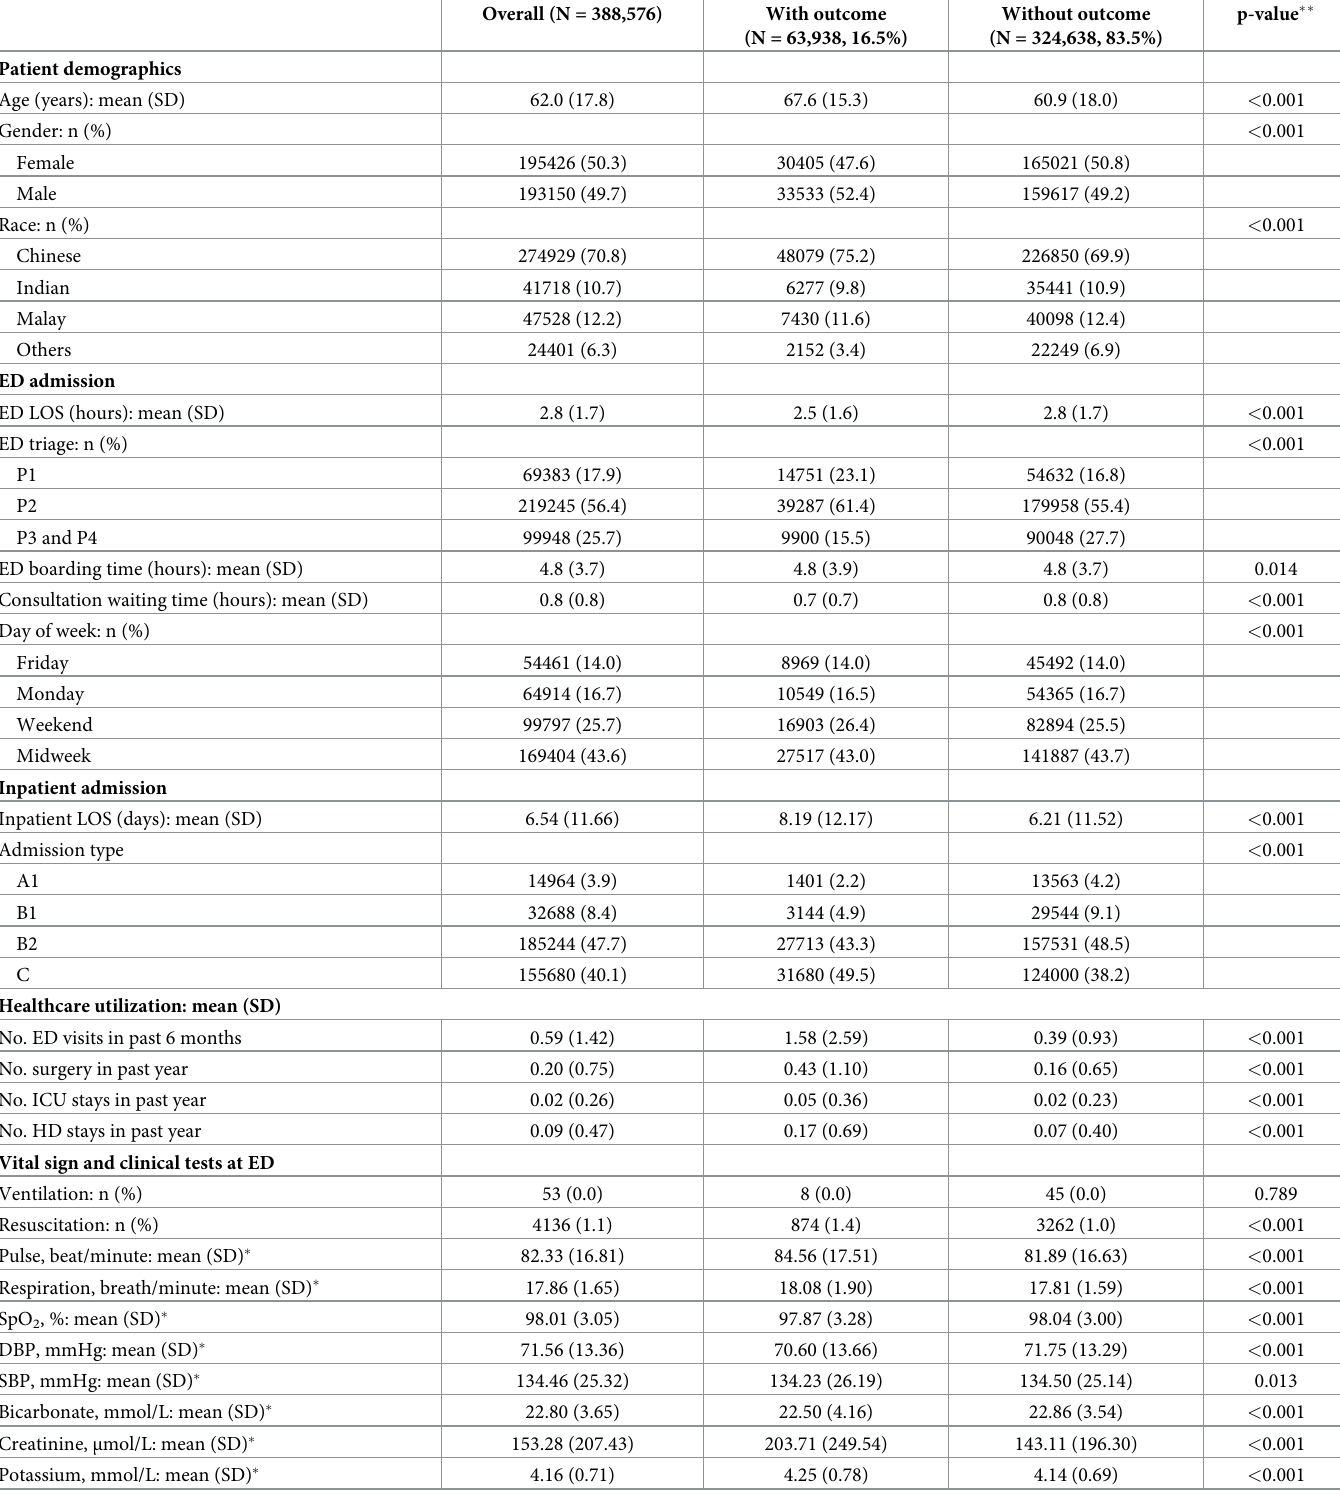
Table 1. Descriptive statistics of the full cohort. The outcome is death or readmission within 30 days after hospital